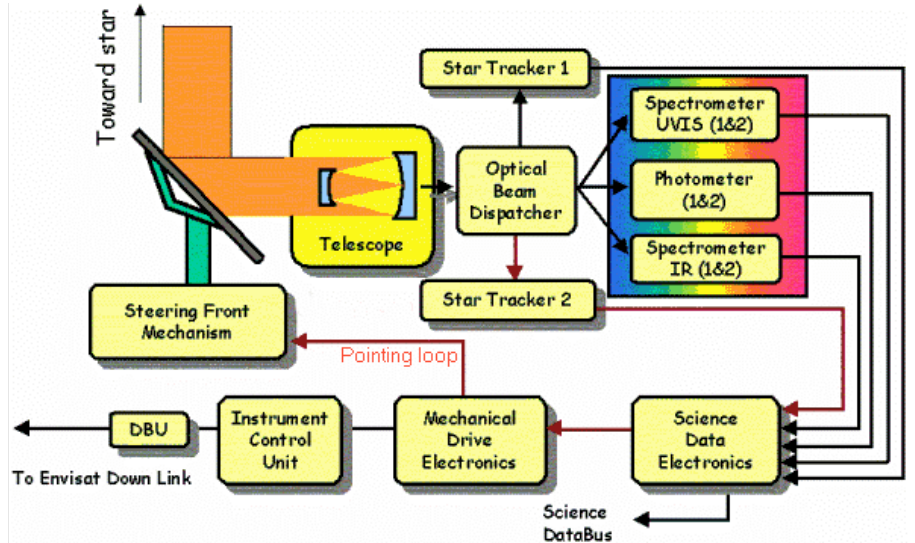
Fig. 4 : GOMOS Instrument block diagram. Fig. 4. GOMOS Instrument block diagram. - 69 -